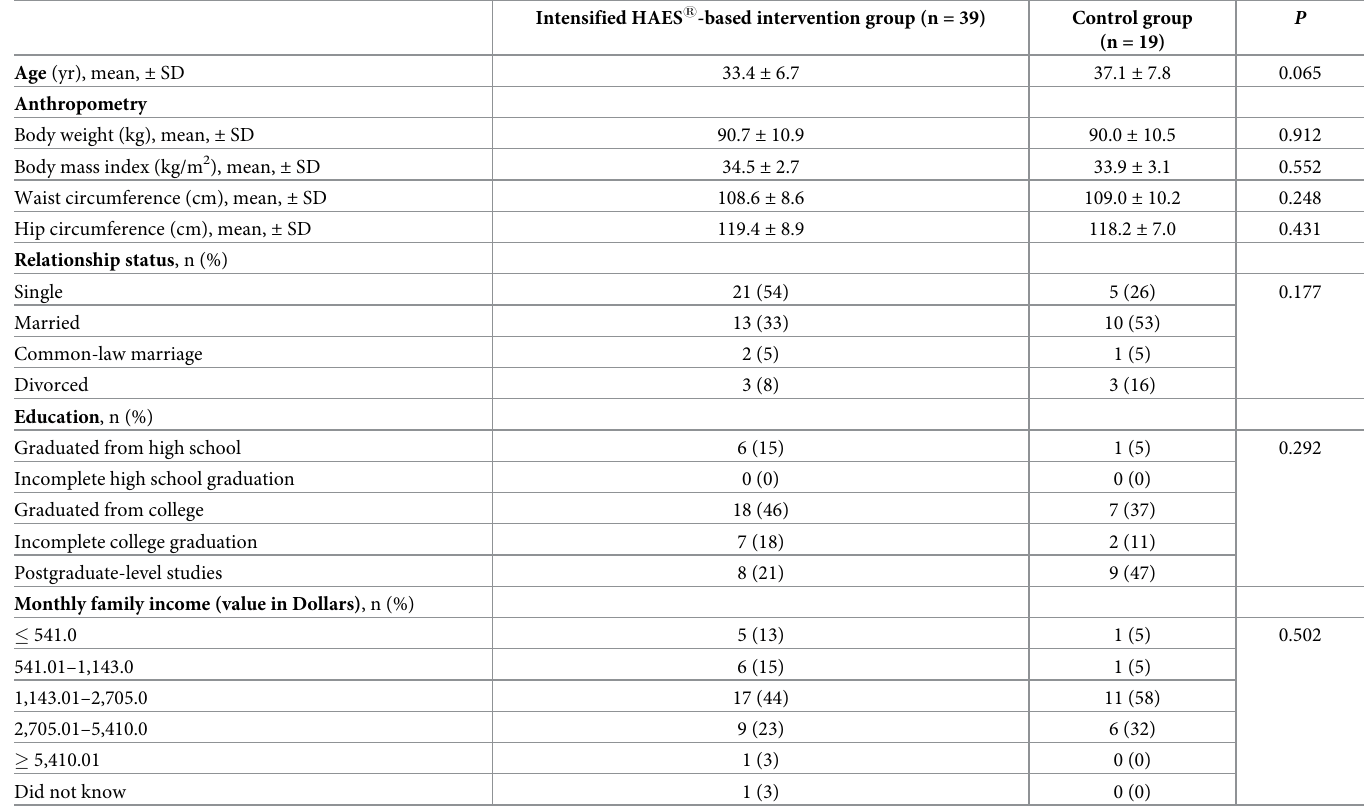
Table 2. General characteristics of women participating in a randomized controlled trial based on the Health at Every Size 1 approach.